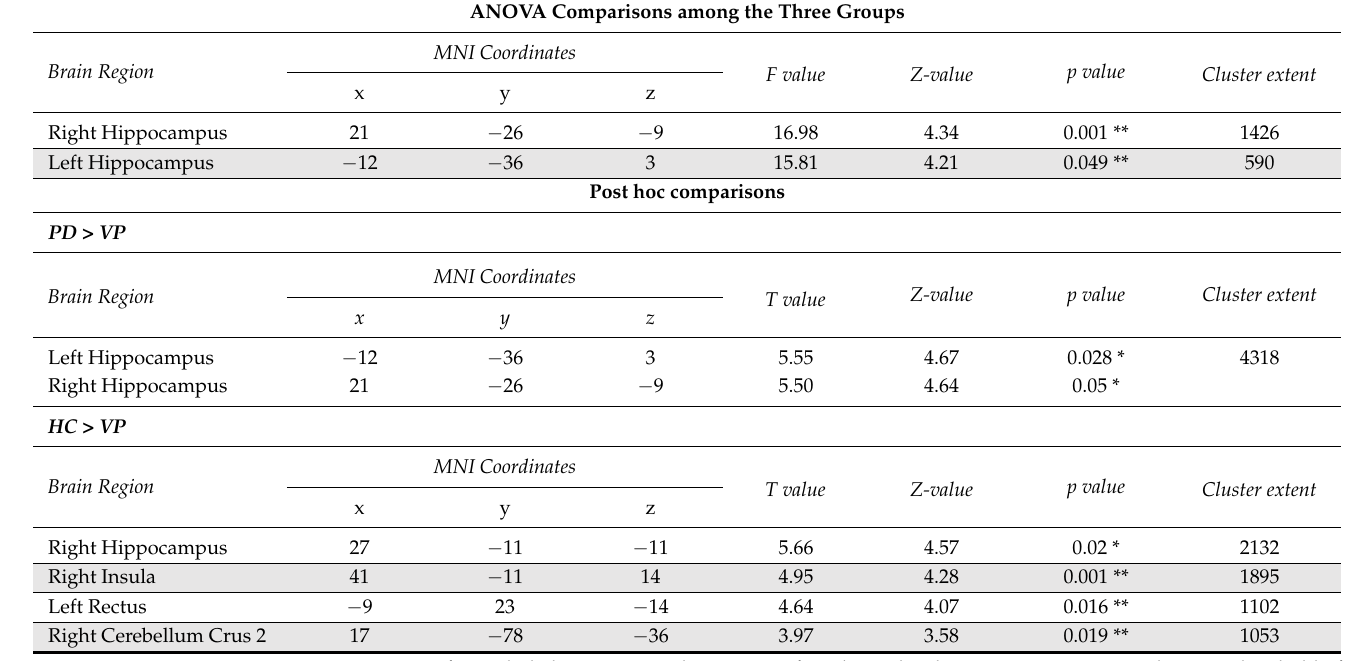
Table 3. Structural covariance analysis. Seed region: Left